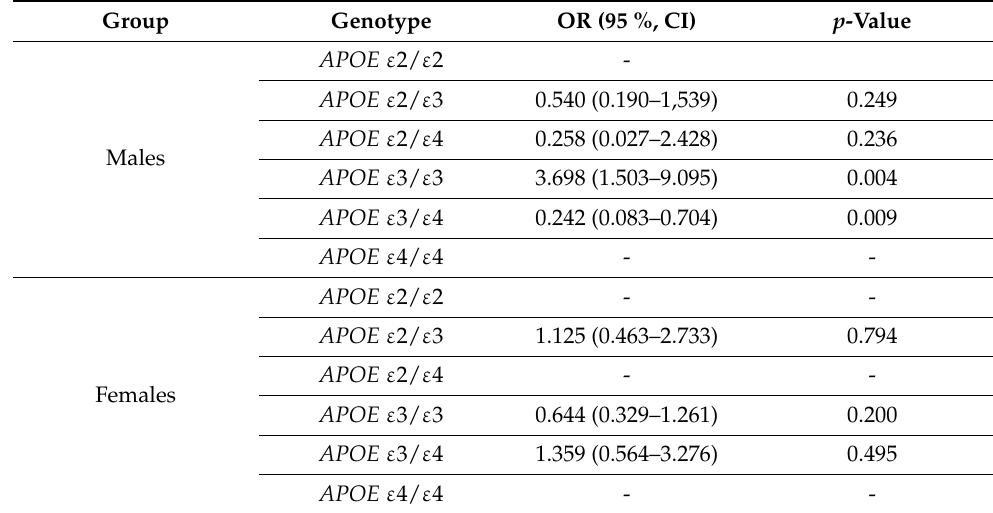
Table 5. APOE binary logistic regression in patients with ON and controls grouped by gender.